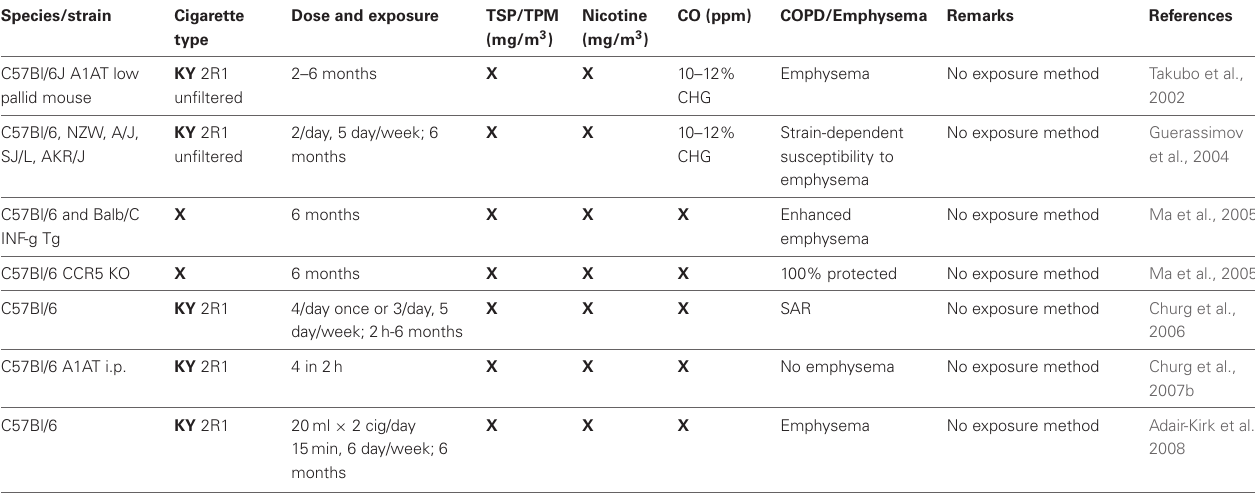
Table 3 | Animal studies where the exposure (mainstream or second hand smoke) is not known.